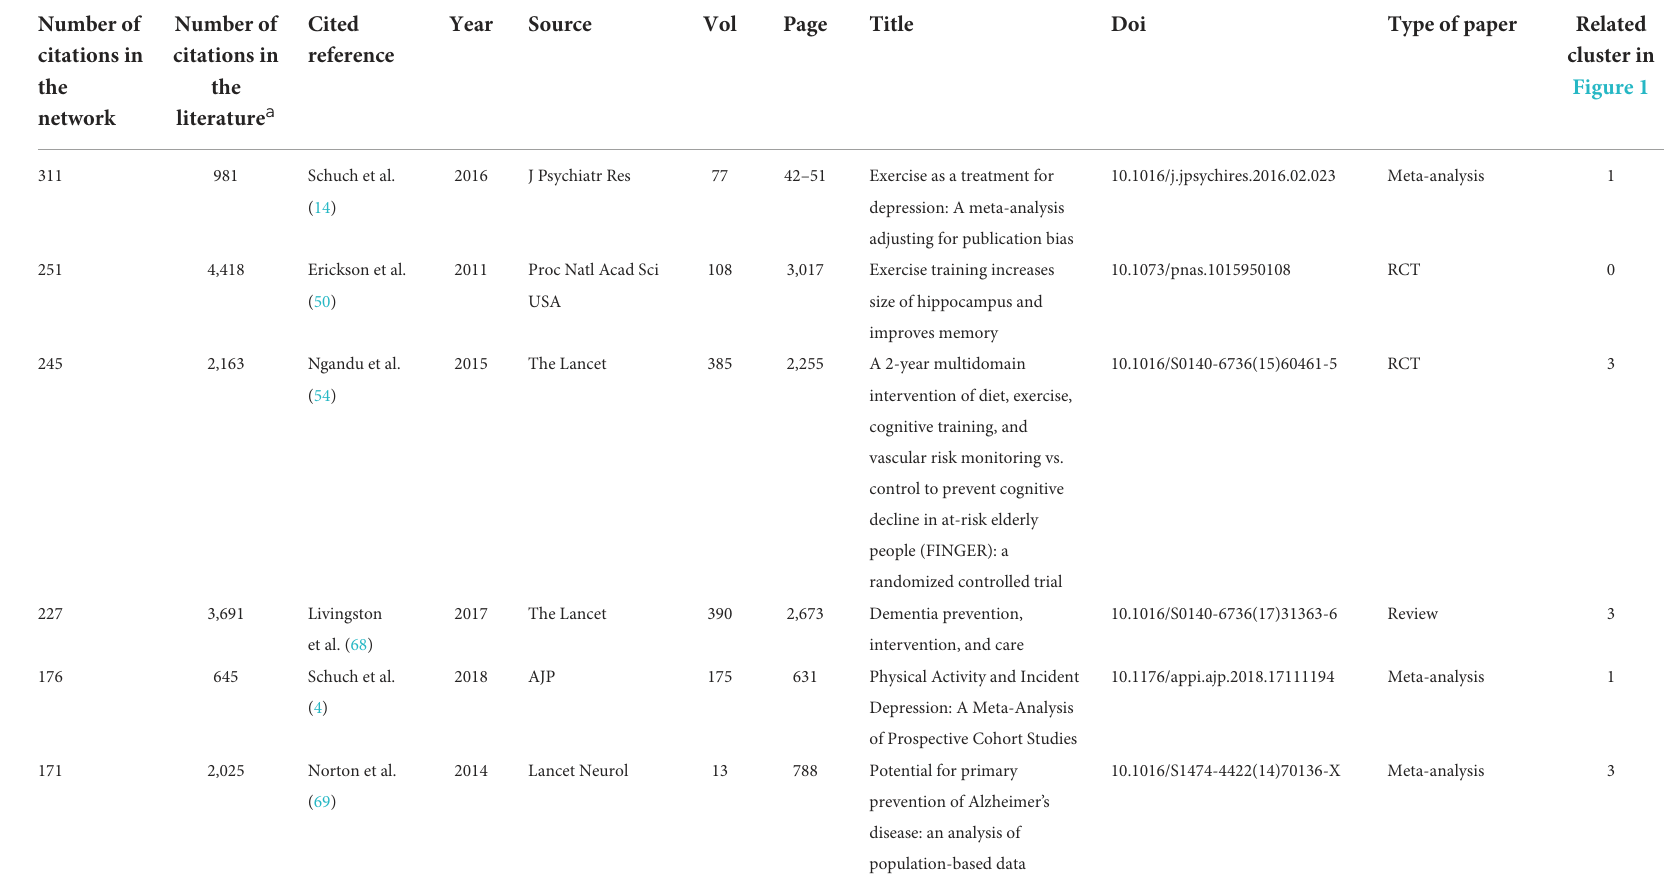
TABLE 1 The top 10 most cited journals and